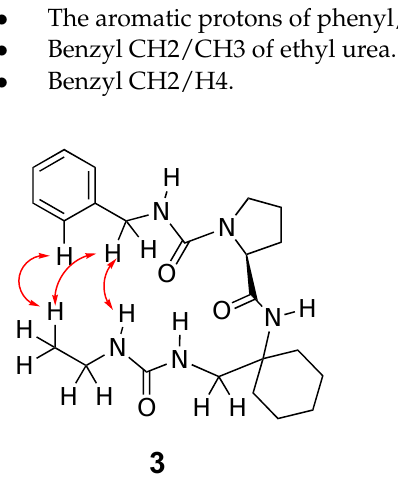
Figure 11. Summary of NOE of compound 3 at − 10 °C, t-mix = 600 ms (CDCl 3 , 500 MHz).